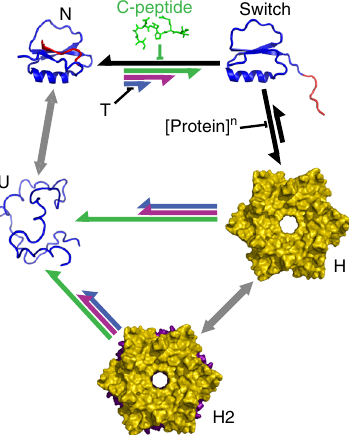
Fig. 8 A thermodynamic model of allosteric assembly via fold switching. The scheme represents the thermodynamic model for allosteric assembly of the engineered CI2 variants and its control via temperature and concentration of C-peptide. All the engineered variants populate the same fi ve species: native monomer (N), fold-switched monomer (switch), hexamer (H), dodecamer (H2) and unfolded monomer (U). The length of the arrows represents the relative propensity for each step in the system. Black and gray arrows represent equilibria that are common to all CI2 variants (not modi fi ed by our strategy). Colored arrows represent the speci fi c behavior of each engineered variant: (blue) CI2 eng ; (magenta) I59A-CI2 eng ; (green) CI2 1 – 58 . Each effector (temperature, protein concentration and C-peptide) favors a speci fi c step in the mechanism as indicated in the